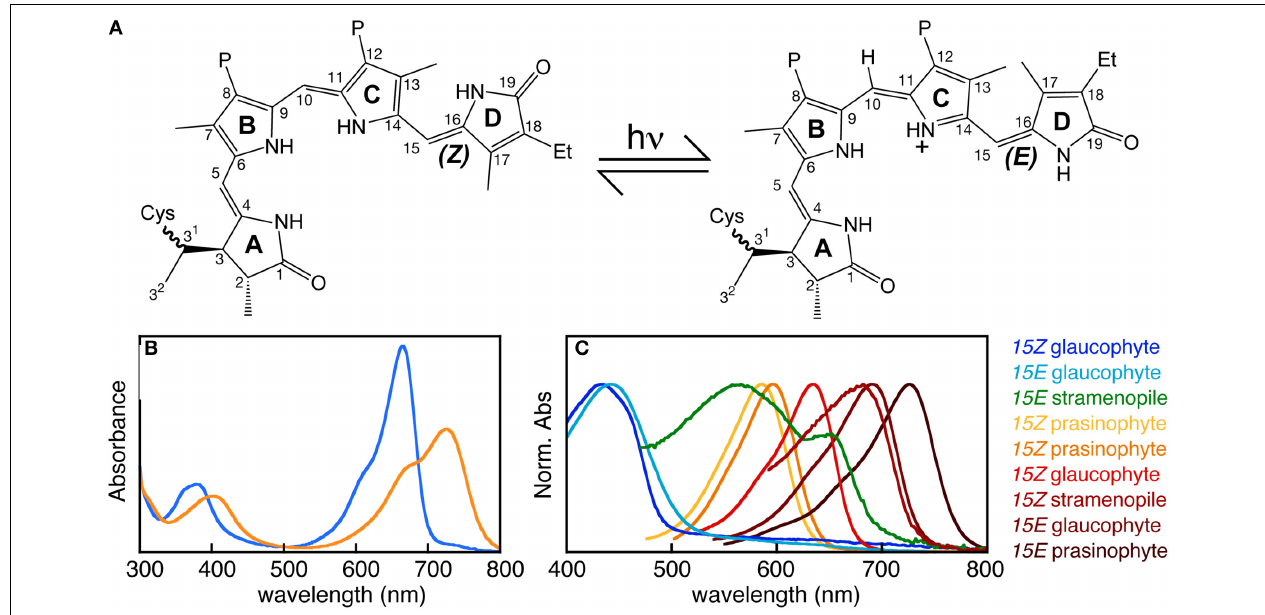
FIGURE 5 | Perception of light by phytochrome. (A) Absorption of light by phytochrome triggers reversible photoisomerization of the bilin 15,16-double bond, resulting in photoconversion between two photostates. Rings and numbering system are indicated for a covalent PCB adduct to a conserved